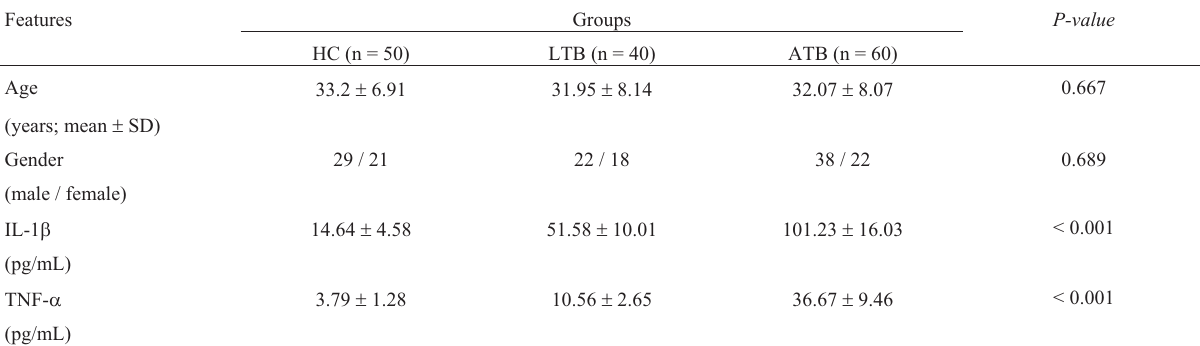
Table 1 - Demographic and clinical characteristics of the study population